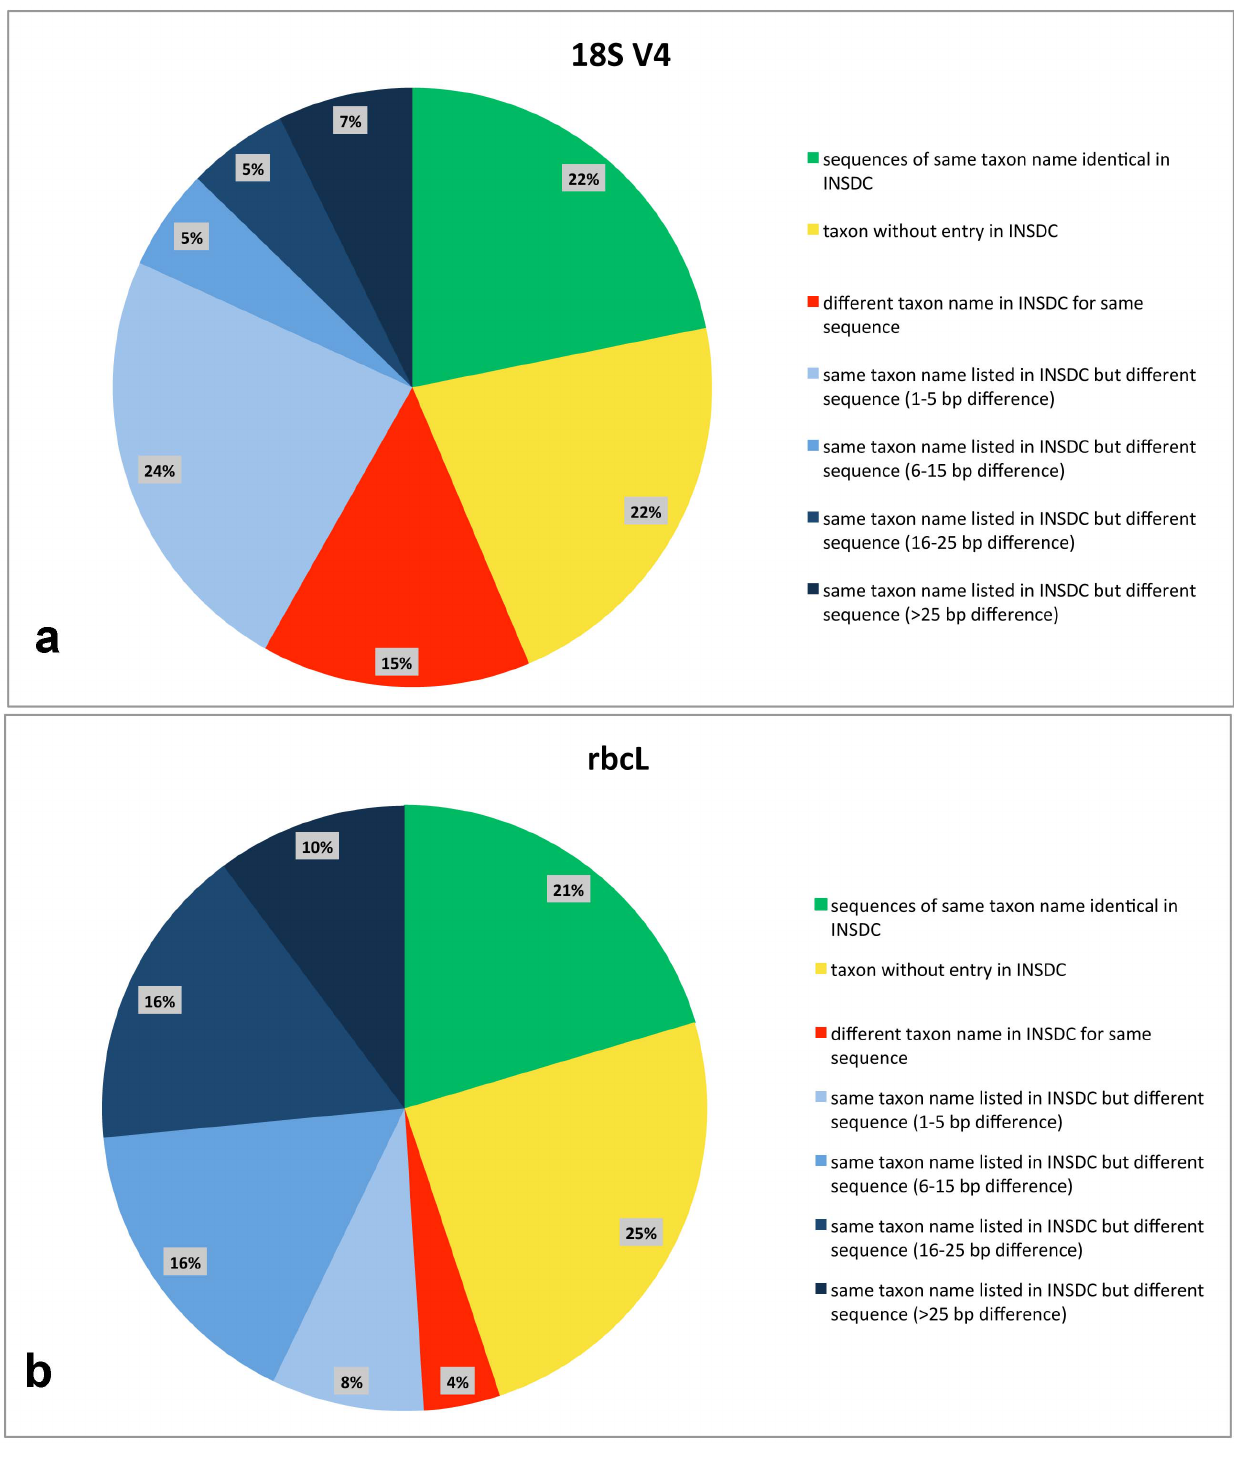
Figure 5. Chart giving classes of base pair (bp) differences for both markers (18S V4, rbc L) between here presented molecular data and corresponding data from INSDC databases. Inferred from data in Table 3.